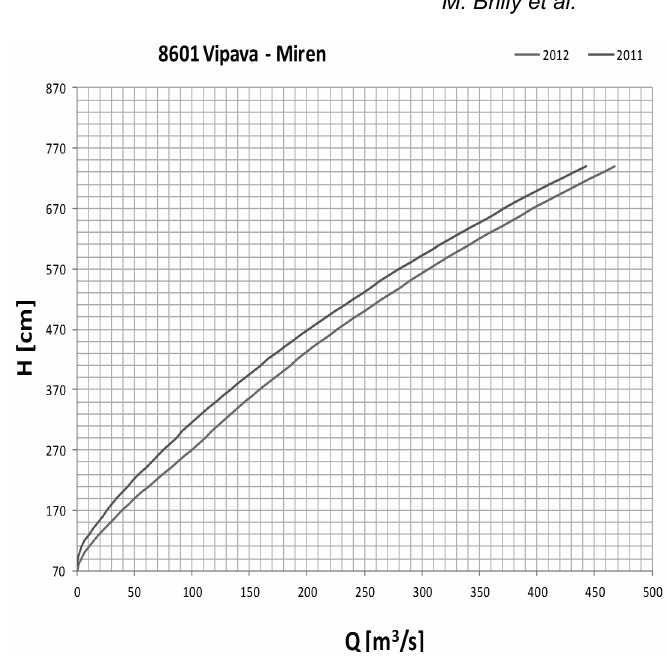
Fig. 4 WS Miren rating curve from year 2011.